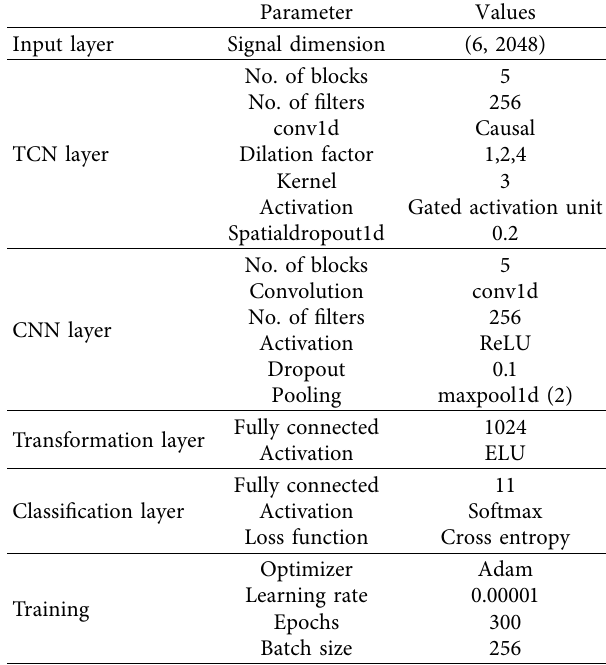
Table 1: Summary of the model architectural